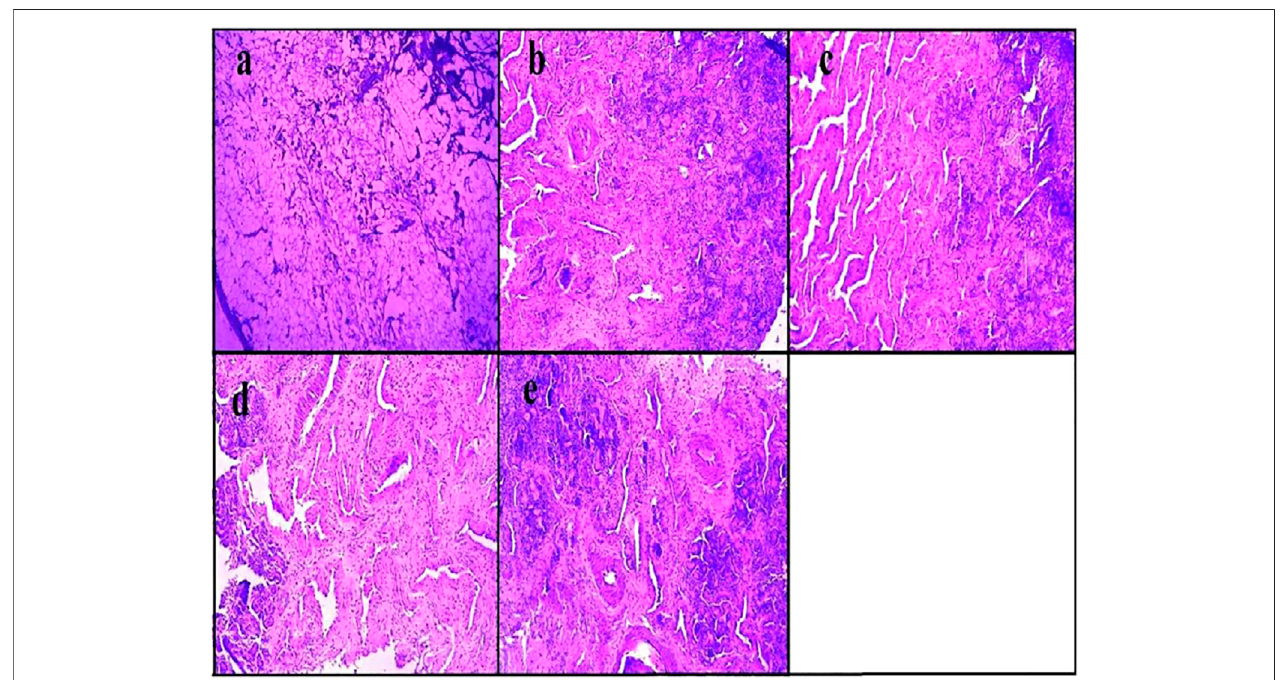
FIGURE4| Histopathologicalassessmentofnasalmucosaconditionafter2 hexposureof (A) iso-propylalcohol(positivecontrol), (B) simulatednasal fl uid(pH6.4) (negative control), (C) asenapine mucoadhesive nanoemulsion, (D) asenapine nanoemulsion, and (E) blank mucoadhesive nanoemulsion (Kumbhar et al., 2020).